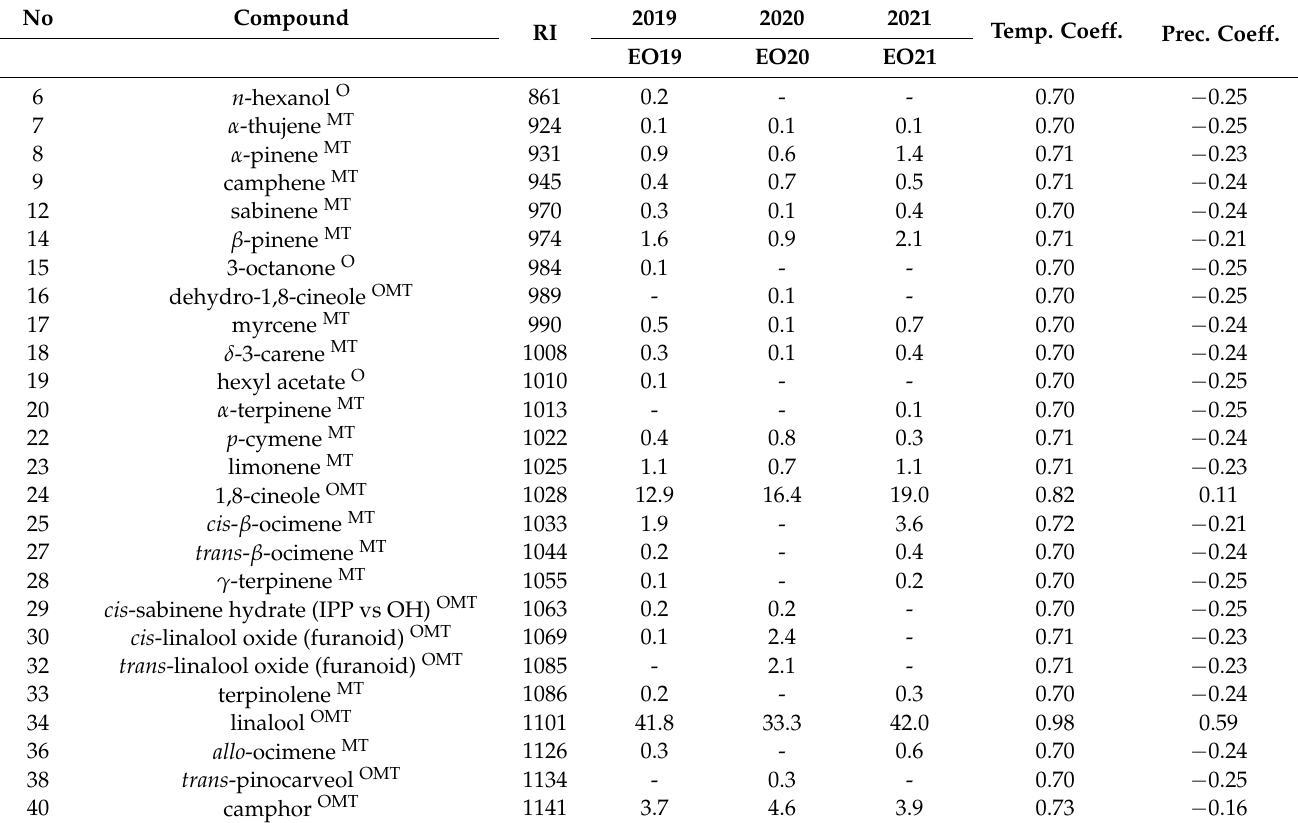
Table 3. L. x intermedia cv. ‘Budrovka’ essential oil composition during three growing years and related multiple correlation coefficients with the observed temperature and precipitation